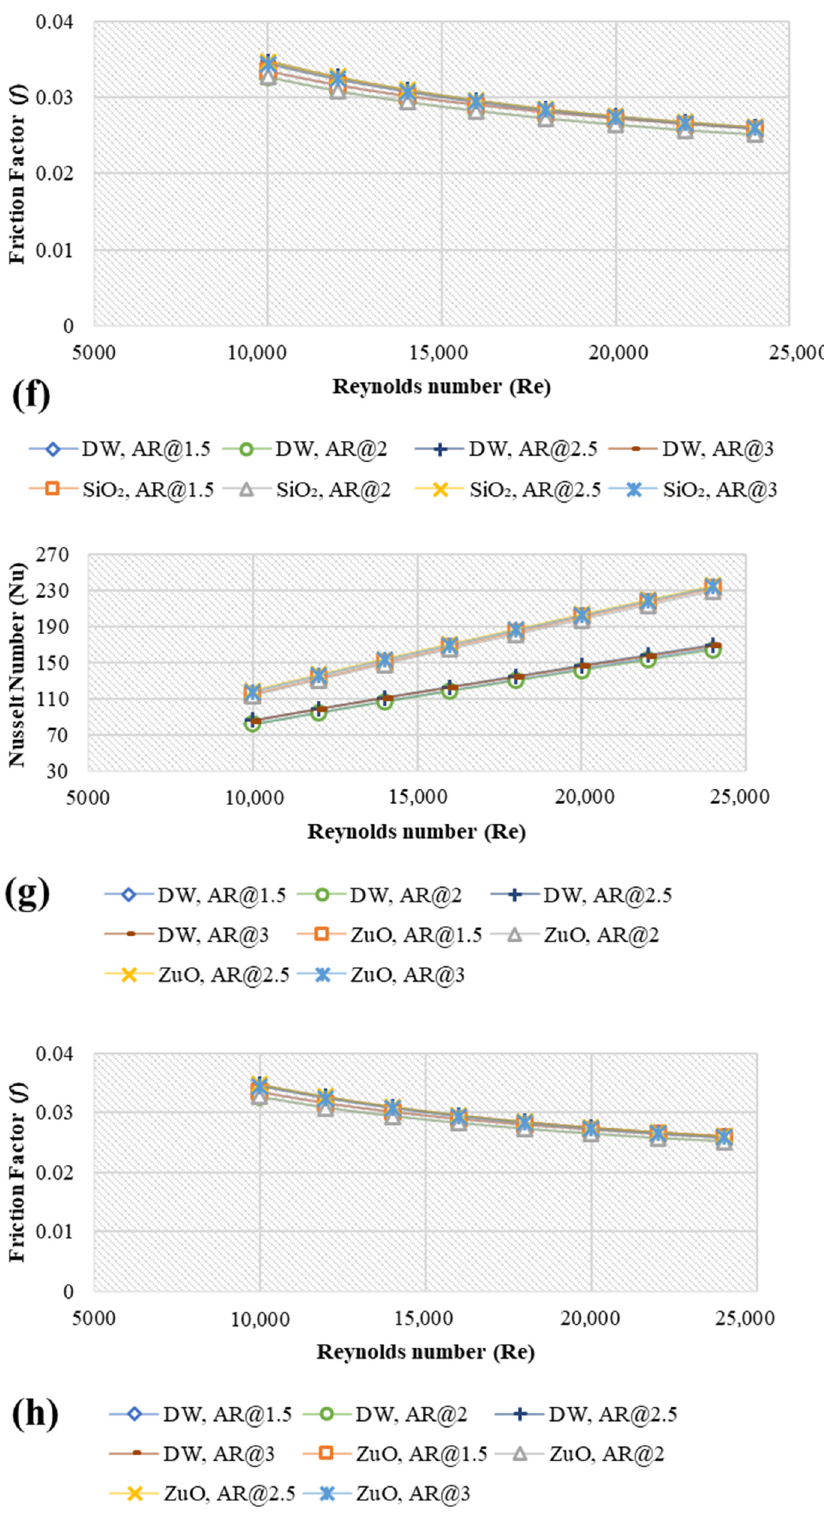
Figure 9. Simulation data of average Nusselt number and friction factor for different metal oxides and different aspect ratios at 4 vol.%, 20 nm, and 293 K; ( a ) Nu-Al 2 O 3 , ( b ) f -Al 2 O 3 , ( c )